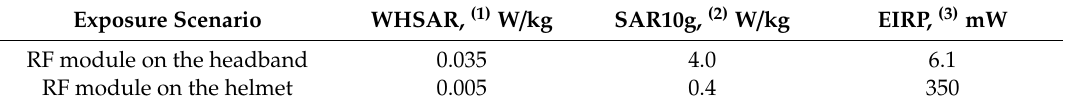
Table 2. Specific energy absorption rate (SAR) values in the head of the user of an